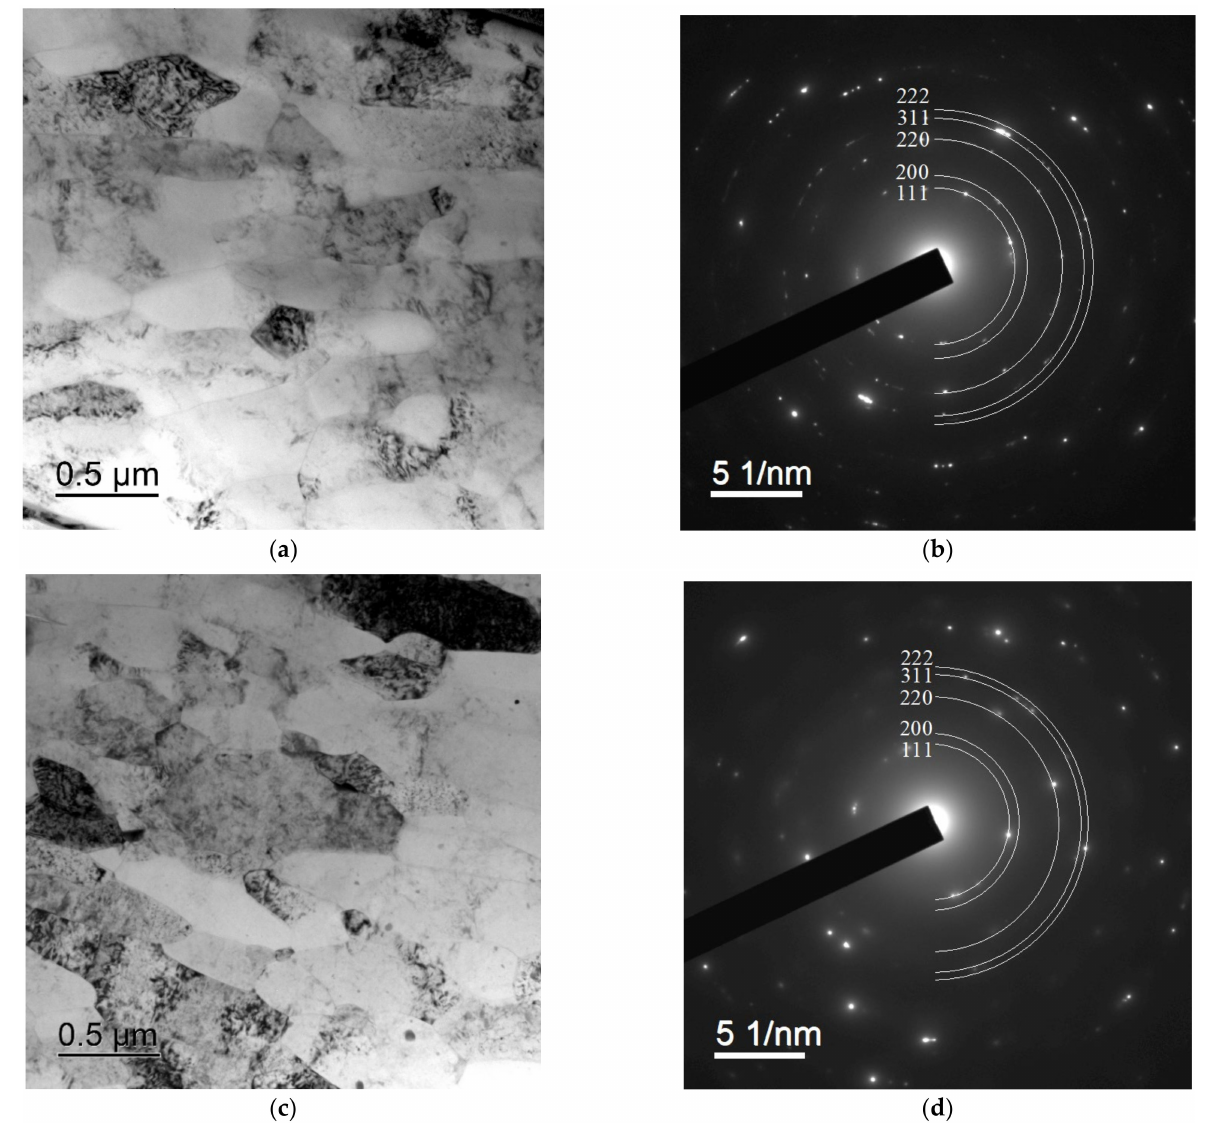
Figure 4. Microstructure of the central part of a bimetallic wire that was made from Alloy #2 ( a , b ) and Alloy #3 ( c , d ): ( a , c ) general view; ( b , d ) electron diffraction pattern. Transmission electron microscope